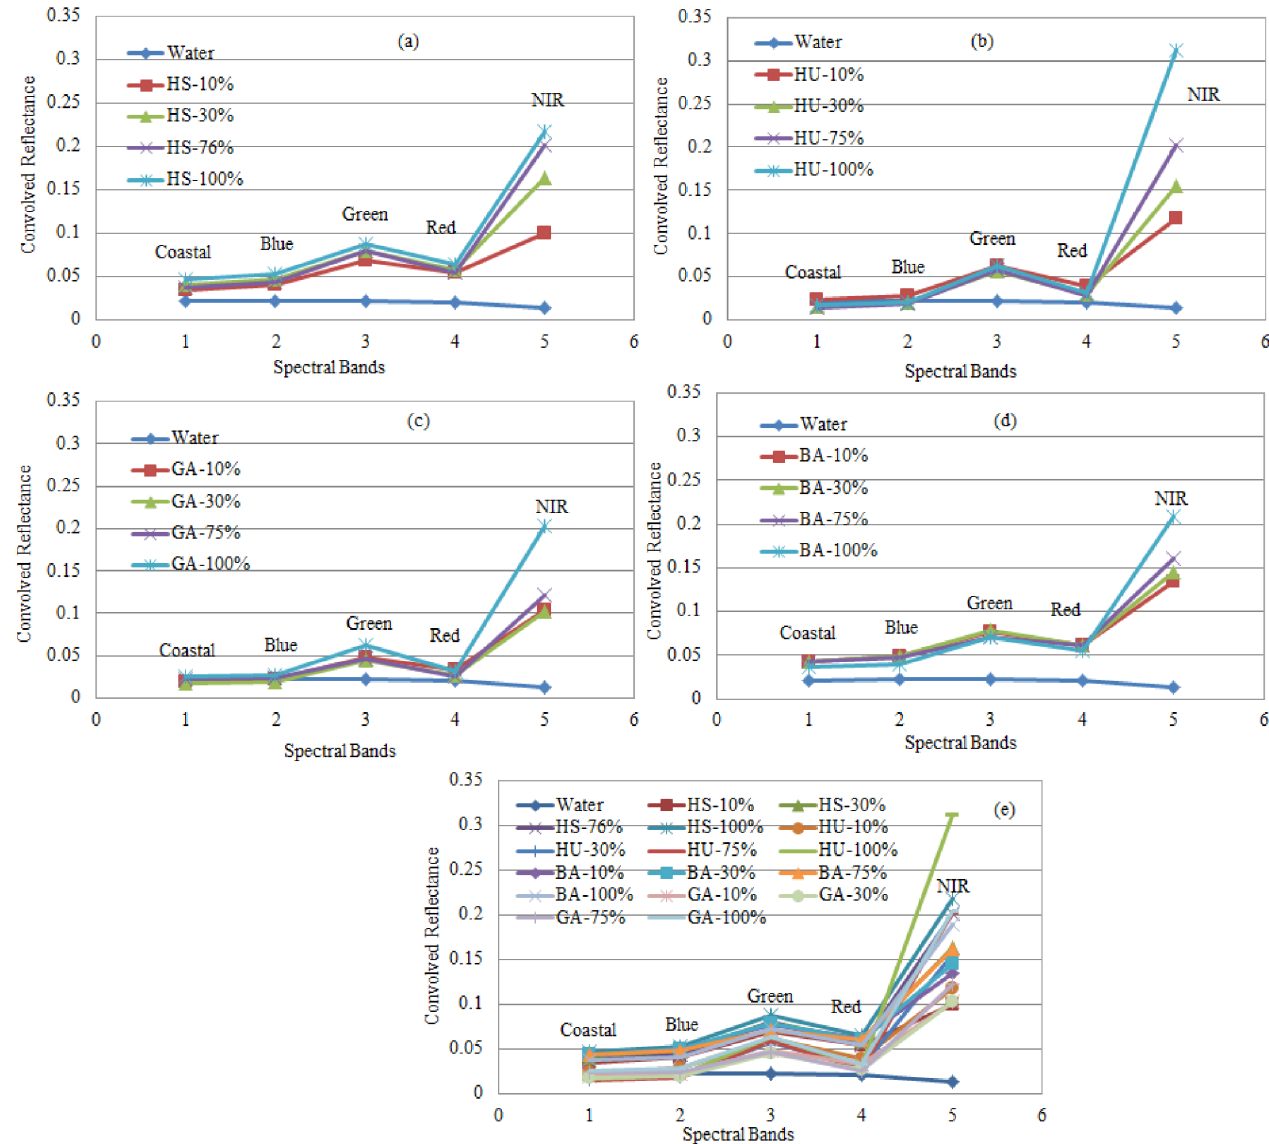
Figure 9. Seagrass, algae, and seawater reflectances resampled and convolved in VNIR bands of Sentinel-MSI (or Landsat-OLI): HS (a) , HU (b) , GA (c) , BA (d) , and all samples (e)